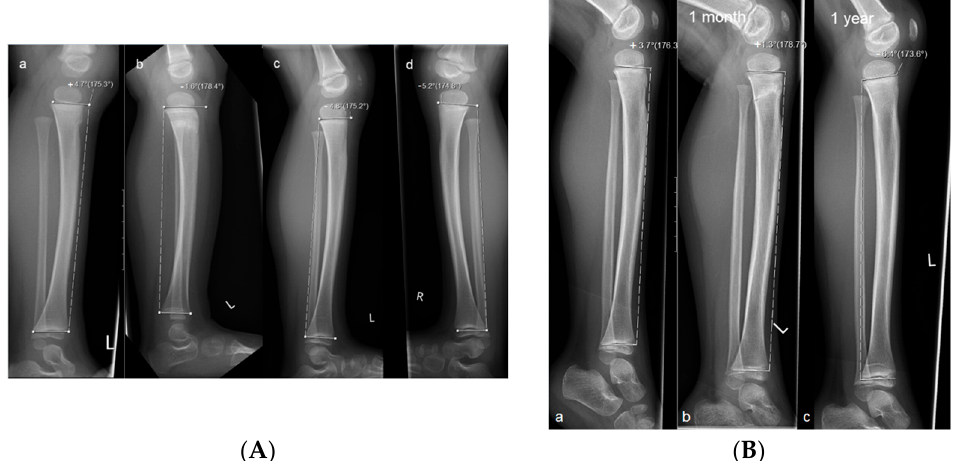
Figure 1. Measurements of the anterior tilt angle of the proximal tibia in children with trampoline fracture. ( A ) Radiographs of a child with a torus fracture. Measurements were taken (a) on the day of the accident; (b) after one month, and (c) after one year; (d) x-ray of the healthy opposite leg. The negative anterior tilt angle ( − 4.8°) at one year indicates complete remodeling. ( B ) Radiographs of a child with a complete fracture. Measurements were taken (a) on the day of the accident, (b) after one month, and (c) after one year. The negative anterior tilt angle at one year ( − 6.4°) shows complete remodeling.